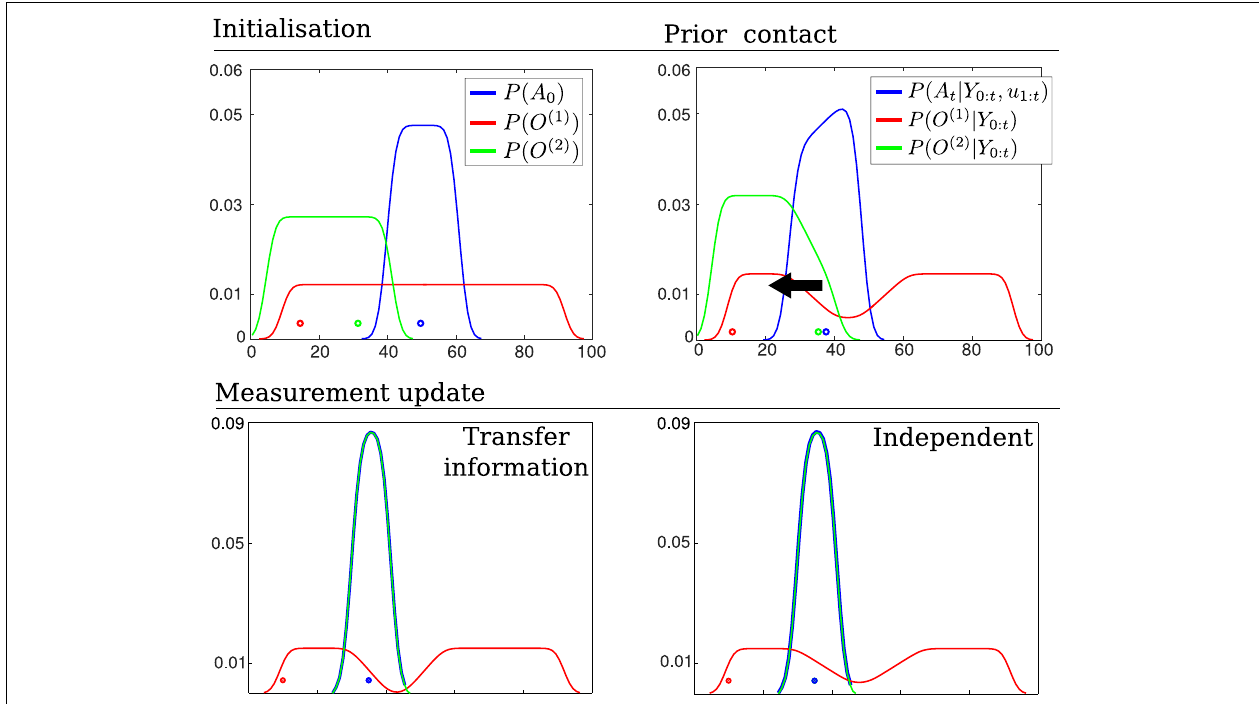
FIGURE 10 | Transfer of information (marginals). Top left: Initial beliefs of the agent and object’s location. The agent moves to the left until it senses object O (2) . Top right: Marginals prior the agent entering in contact with the green object, see Figure 9 ( Top ) for an illustrate of the joint distributions. Bottom left: resulting marginals after setting the agent marginals of each joint distribution equal A ( 1 ) t = A ( 2 ) t according to Algorithm A2 . The object marginal P ( O ( 2 ) | Y 0 : t ) is recomputed. Bottom Right: resulting marginals in which the objects have no influence on one another. Note that a transfer of information has caused a change in the marginal O (1) .